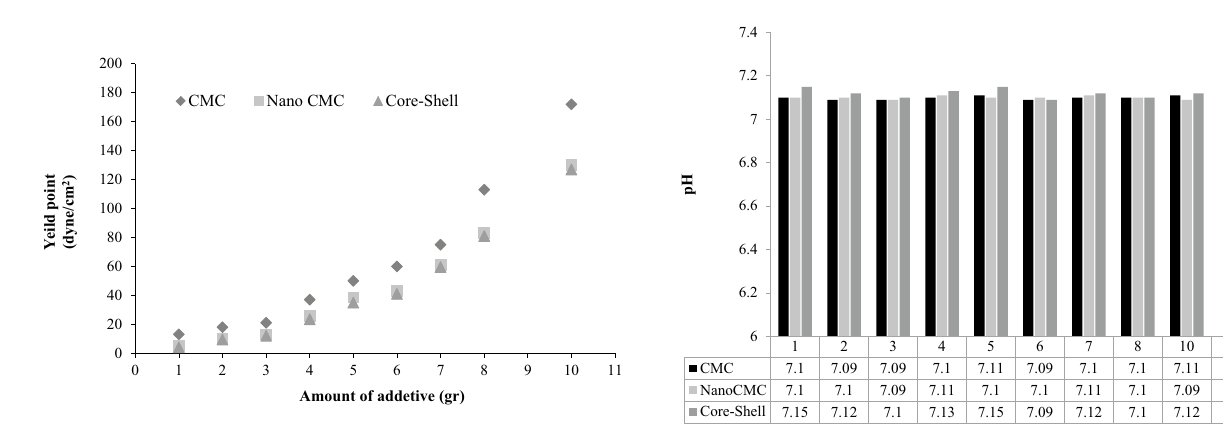
Fig. 13 Comparison of apparent viscosity of drilling fluid with bulk CMC, nanoCMC and core–shell nanocomposite additives